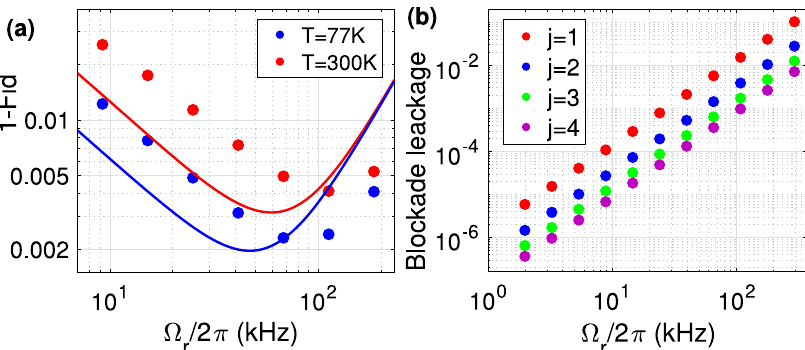
Fig. 4 Optimal gate performance. a The in fi delity of C 4 -NOT operation as a function of Rydberg exciting Rabi-frequency for the setup of Fig. 1d with the interaction values quanti fi ed in Eq. (5). The solid line is based on analytic estimates discussed in the text for a square laser pulse while the circles are based on the numerical simulation of Eq. (9), calculated for a Gaussian pulse Ω r e (cid:2) ð t (cid:2) T fi delity quanti fi ed by Eq. (10), encounters spontaneous emission and rotation errors. Different environment temperatures of 77 K and 300 K are considered. b Blockade leakage of the target atom for different qubit con fi gurations with j plaquette atoms in 1 c in two-photon excitation is obtained by Ω 420 = Ω 1013 lasers that are detuned from intermediate level by δ p /2 π = 5 GHz and the frequency Ω r ¼ Ω 420 Ω 1013 2 δ p lasers are locked out of phase with the locking bandwidth of 1 kHz 93 . The results are averaged over the frequency pro fi le of the pulse as discussed in